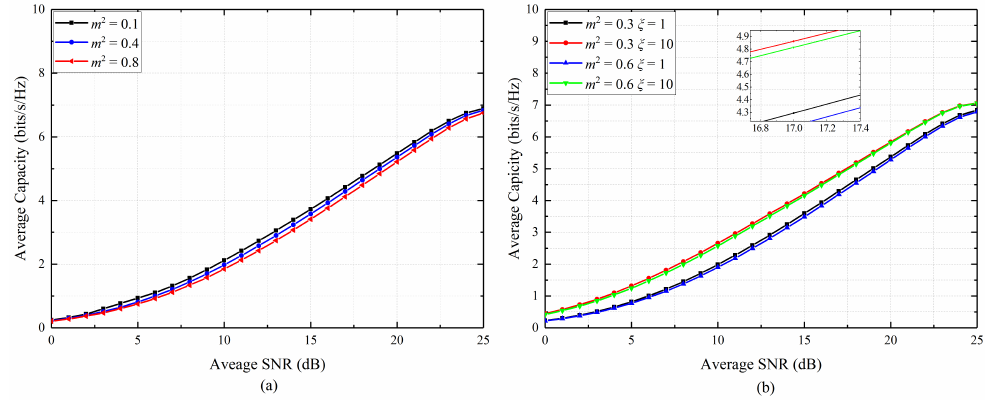
Figure 10. Average channel capacity against average SNR per hop ( a ) for a different scintillation index; ( b ) for different pointing error